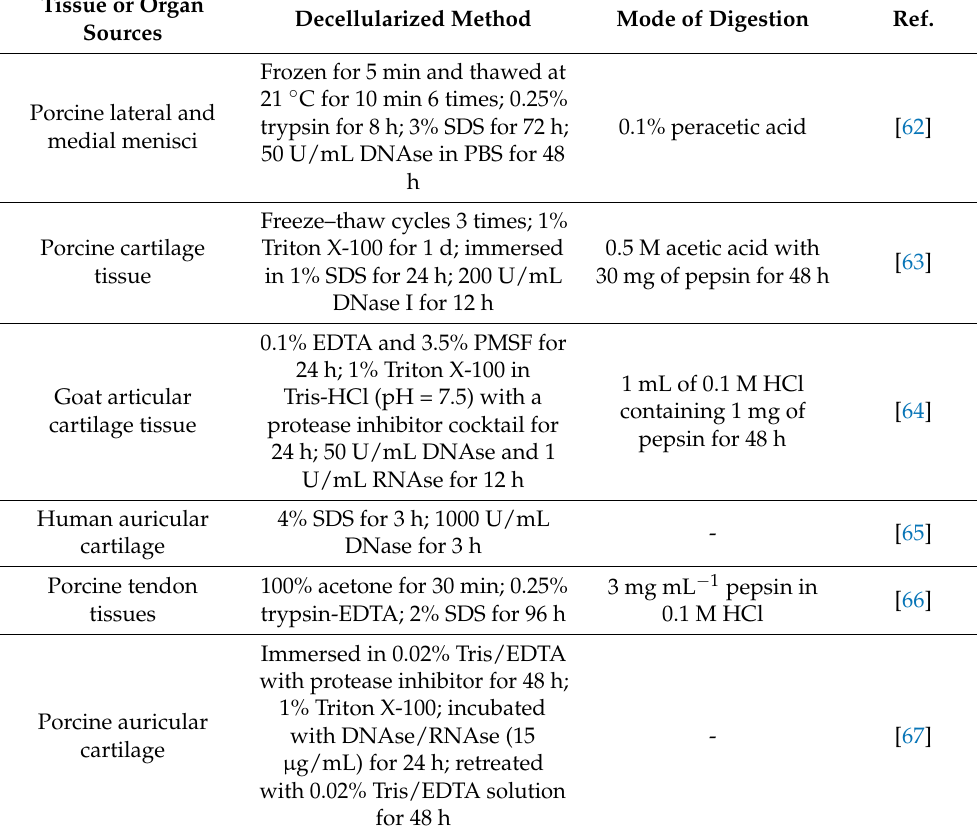
Table 1. Overview of decellularized